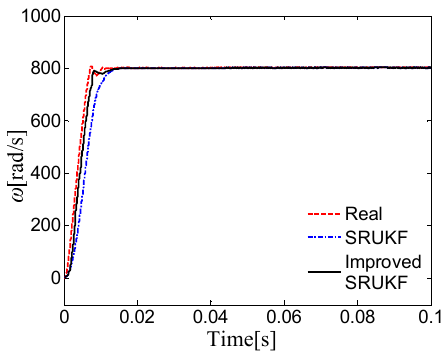
8 of 14 Figure 2. Speed estimation at 50 rad/s. Figure 3. Space position estimation at 50 rad/s.